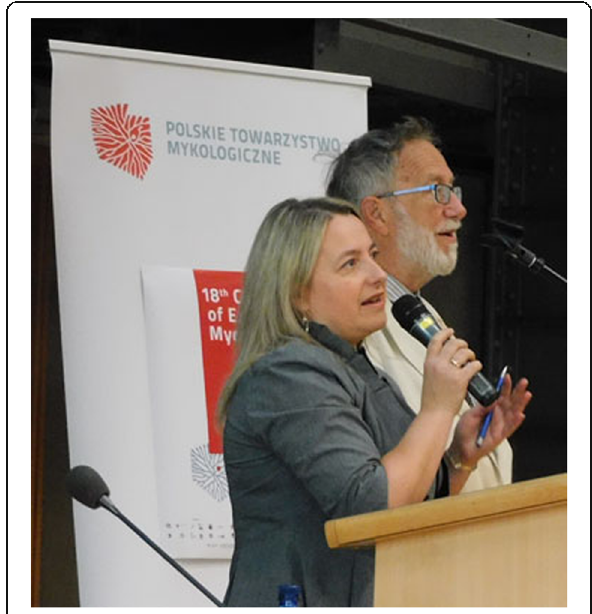
Fig. 2 David Minter (President, European Mycological Association) and Magdalena Fr ą c (President, Polish Mycological Society) at the opening of the